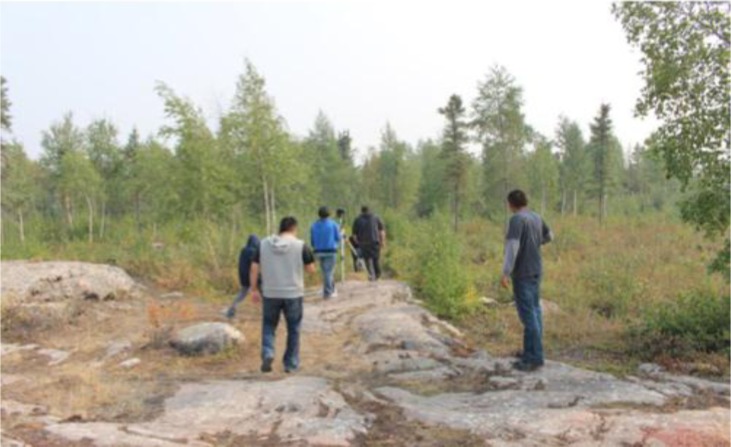
Youth and facilitators in action, shooting scenes for the music video We Write the Future. Photo credit: Sahar Fanian.